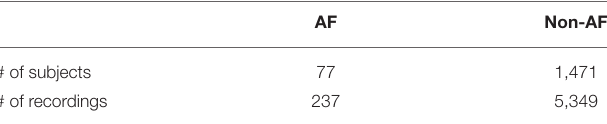
TABLE 4 | Composition of the category irregular rhythm in SSI-A resulting from expert annotation.